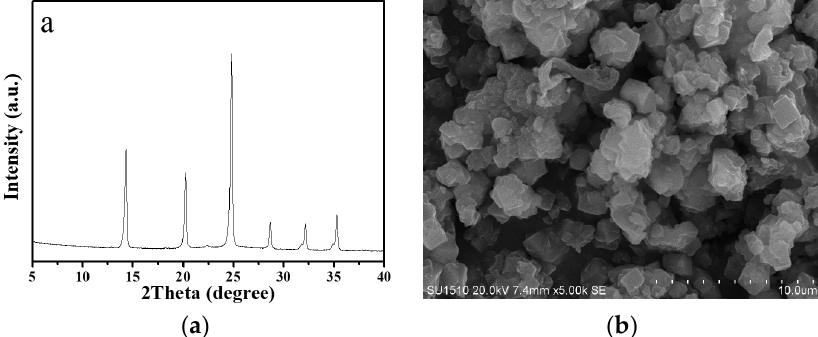
Figure 6. ( a ) XRD pattern and ( b ) SEM image of the as-made S–Si–SOD zeolite synthesized at 200 °C.